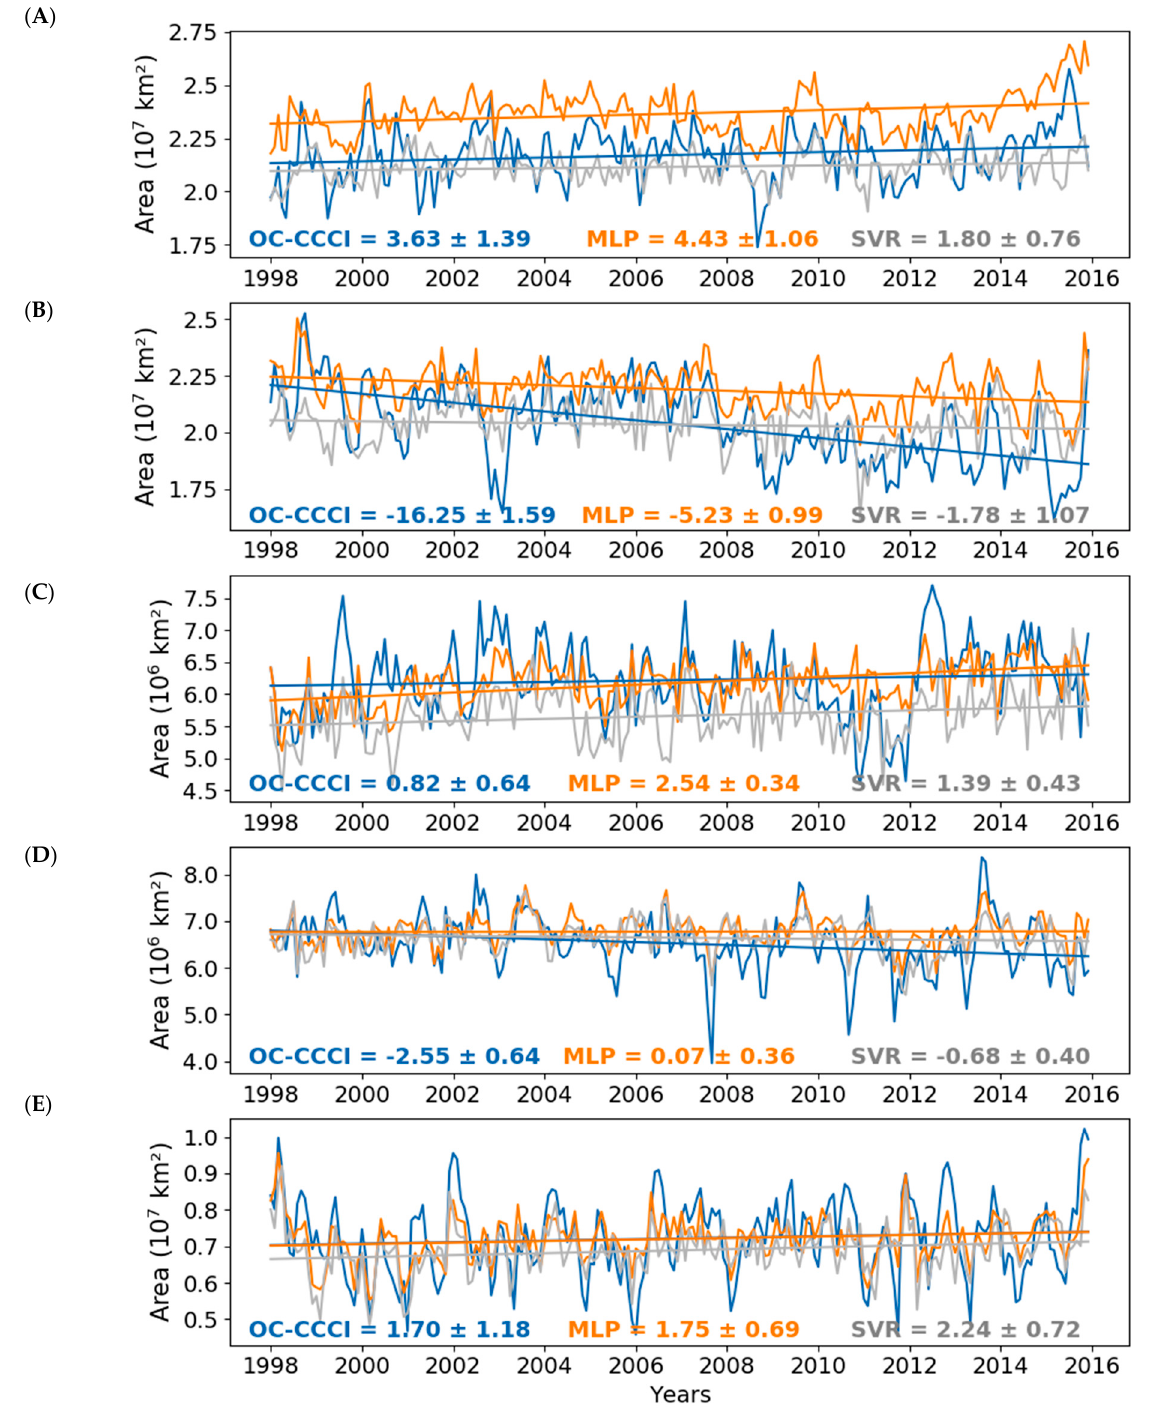
Figure 6. Time series of the monthly mean area (km 2 ) with surface Chl less than or equal to 0.07 mg.m − 3 between 5 ◦ and 45 ◦ N/ ◦ S latitude with the seasonal cycle removed in the ( A ) North Pacific, ( B ) South Pacific, ( C ) North Atlantic, ( D ) South Atlantic and ( E ) Indian Oceans. Chl OC-CCI is in blue, Chl SVR in grey and Chl MLP in orange. Straight lines are the linear trends calculated as in Figure 5. The average trends and standard deviation are also indicated.